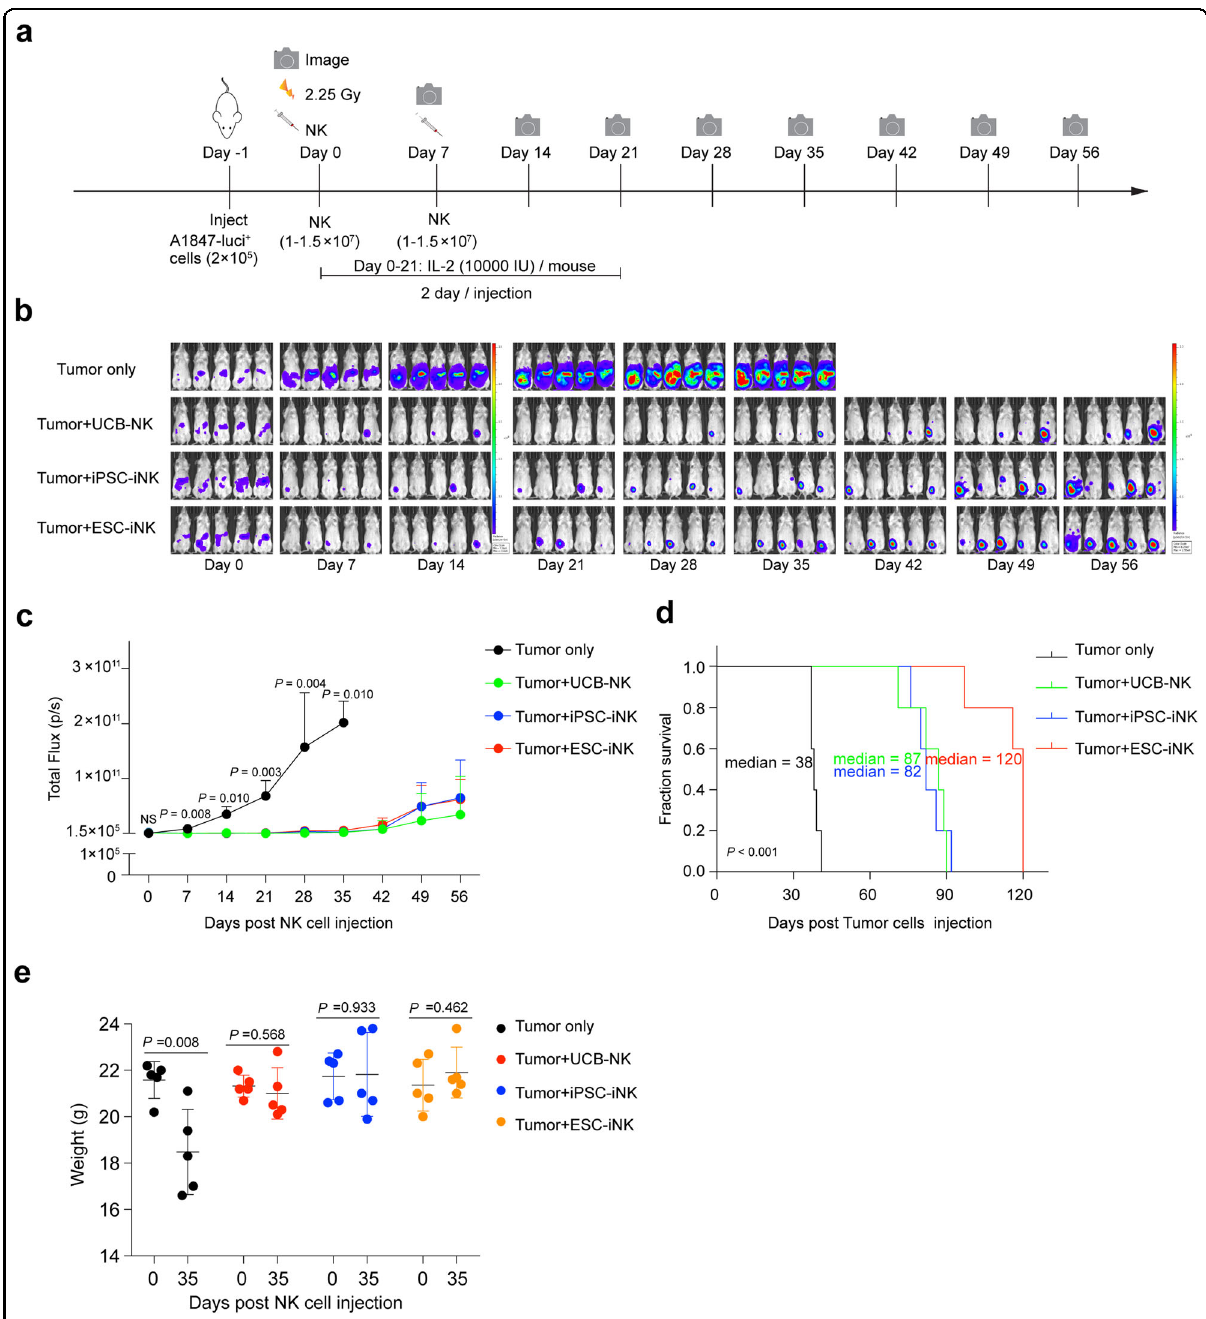
Fig. 5 ESC- or iPSC-derived iNK cells eradicate human tumor cells in xenograft animals. a Procedure design for NK cell treatment in tumor- bearing animals. b BLI images of the xenograft models (Tumor only, Tumor + UCB-NK, Tumor + iPSC-iNK and Tumor + ESC-iNK, n = 5 each group). The radiance indicates tumor burden. c Statistics of the total fl ux (p/s) of the xenograft models (Tumor only, Tumor + UCB-NK, Tumor + iPSC-iNK and Tumor + ESC-iNK, n = 5 each group). d Kaplan-Meier survival curves of the xenograft models (Tumor only, Tumor + UCB-NK, Tumor + iPSC-iNK and Tumor + ESC-iNK, n = 5 each group) ( P < 0.001, Log-rank test). Median survival times were shown. e The body weights of treated mice on Day 35 after iNK cell injection. Data were analyzed by one-way ANOVA ( c ) or two-tailed independent t -test ( e ). NS, not signi fi cant. ESC: human ESC line hPSC- 2; iPSC: human iPSC line